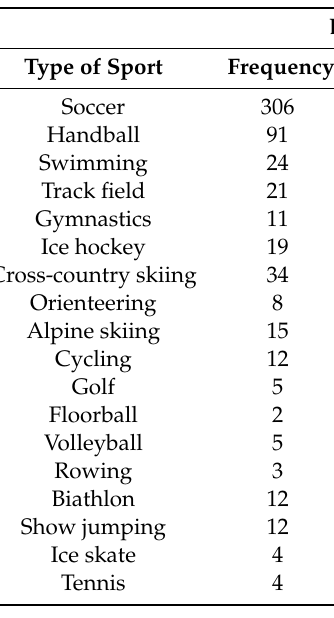
Table 2. The di ff erent sports reported by the 630 participants (two